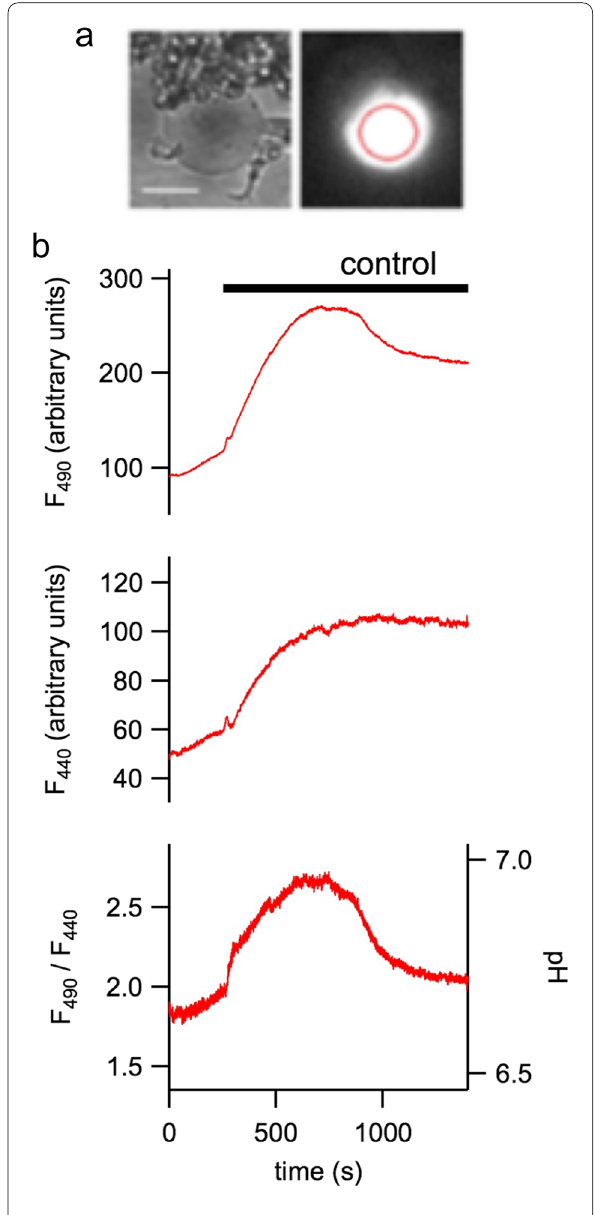
Fig. 5 The loading phase of the vacuole with the proton sensitive fluorophore BCECF. a The left panel shows a bright-field image of a micropipette placed on an isolated vacuole. Scale bar, 10 μm. The whole-vacuole configuration allows the loading of the fluorophore inside the vacuolar lumen. In the right panel the fluorescence image of the same vacuole was obtained with a 490 nm excitation light and detected using a 515-nm bandpass emission filter. The red circle is the region of interest (ROI) where fluorescence is evaluated. b After establishment of the whole-vacuole configuration it is possible to follow the time course of BCECF fluorescence emission signals, F490 (excitation at 490 nm, upper panel), F440 (excitation at 440 nm, middle panel) and fluorescence ratio (F490/F440 and pH, lower panel). Seal and break-in are obtained in VRS, i.e. the solution able to blast the protoplast, which is changed to control bath solution after about 250 s. Modification of Fig. S2 and S4, from Gradogna et al. (2021), New Phytologist, 229:3026–3036, reprinted by permission from John Wiley and Sons (license number